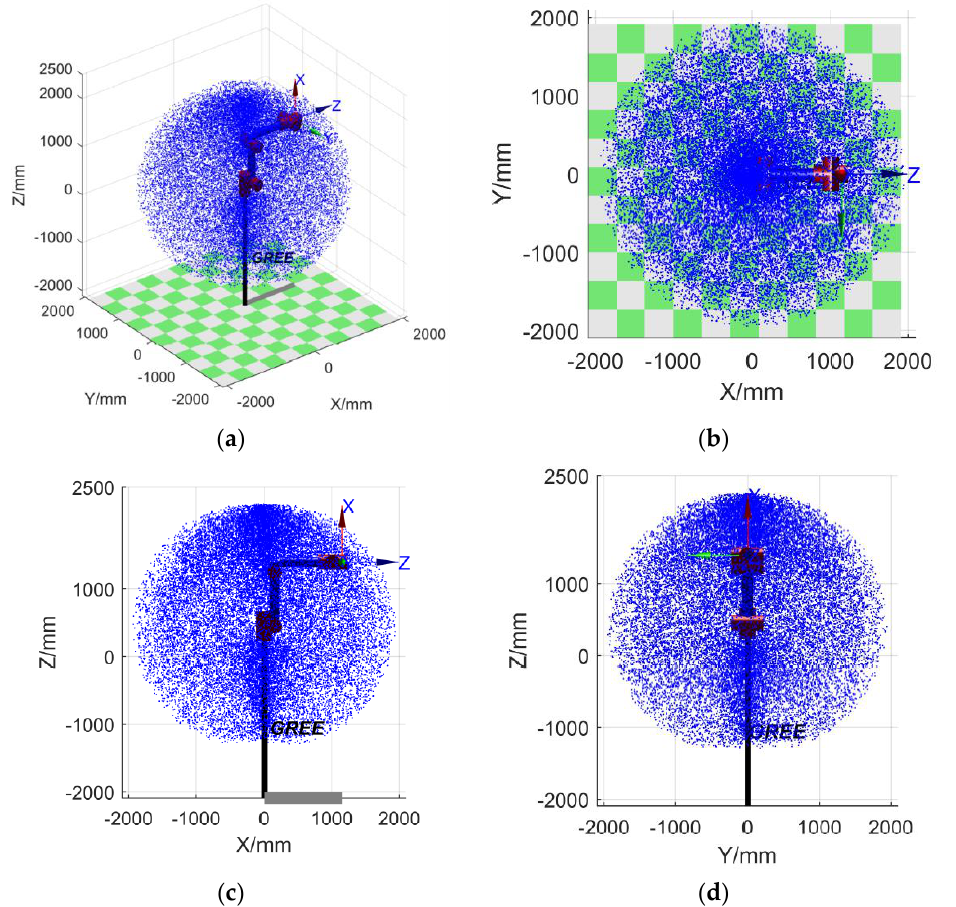
Figure 4. Cloud image of robot. ( a ) Three-dimensional graph, ( b ) X-Y diagram, ( c ) X-Z diagram, ( d ) Y-Z diagram.